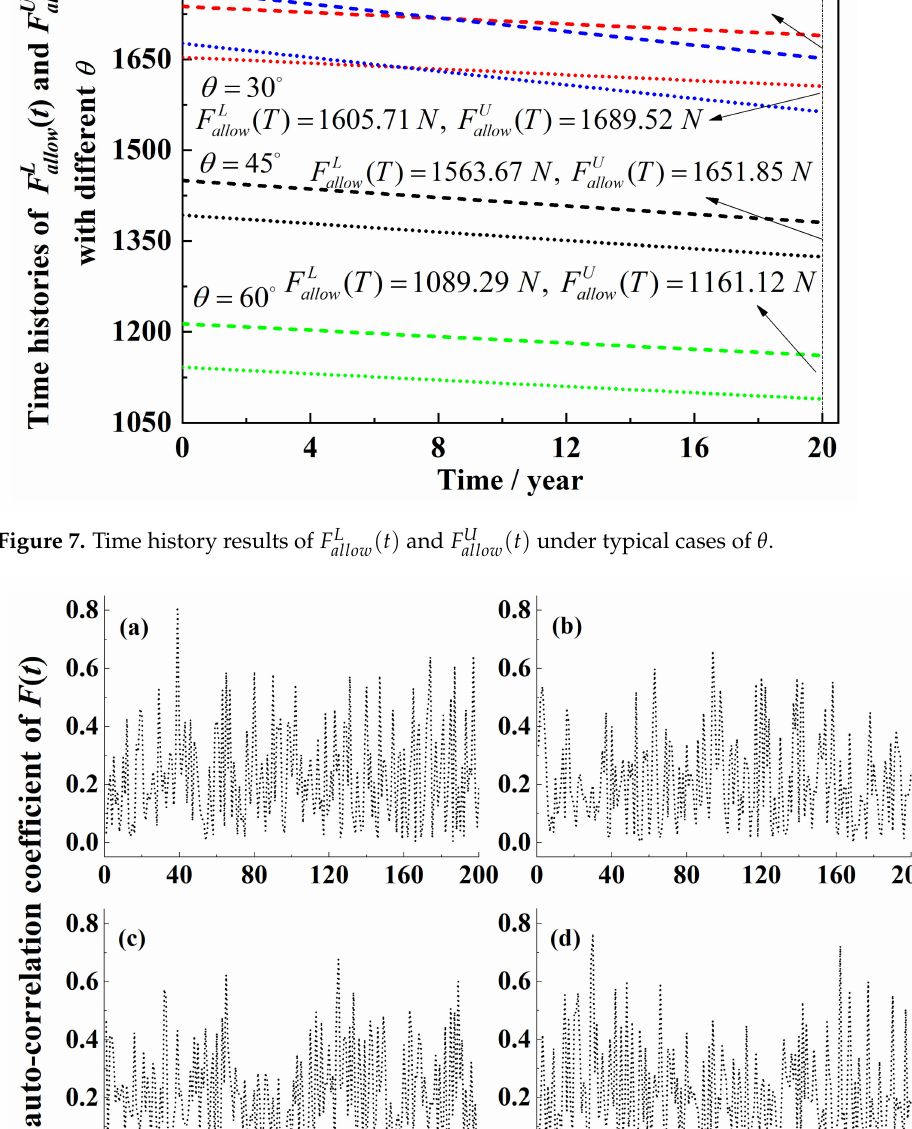
Figure 8. The auto-correlation coefficient function ρ F (( j − 1 ) ∆ t , j ∆ t ) obtained by the novel optimization-based strategy (Case ( a )–( d